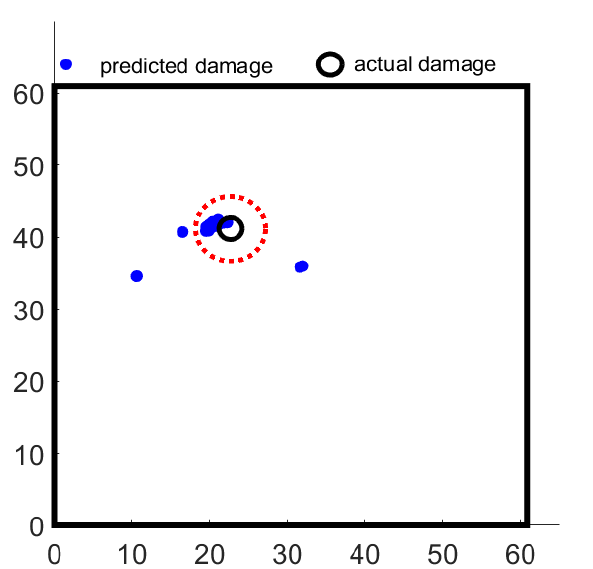
Figure 8. Damage localization for damage 7 for 100 PSO runs (red dotted circle indicates the acceptable region for